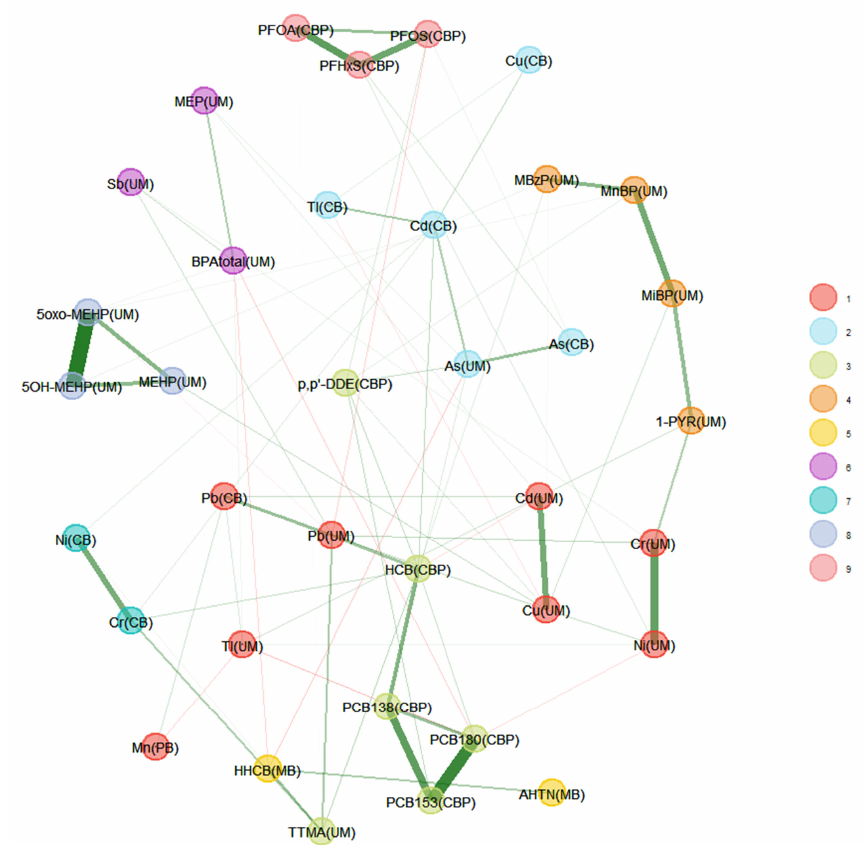
Figure A2. Weighted network for 3xG using the graphical lasso method with bootstrap of 80 iterations. Data were corrected for age, smoking, and BMI. Urinary markers were standardised for creatinine; lipid soluble blood markers were standardised for lipids. Matrices in which biomarkers are measured appear between brackets. Green lines represent a positive dependency between nodes (biomarkers), while red lines represent a negative dependency.